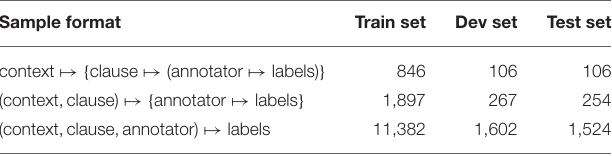
TABLE 1 | Clause-level Fleiss’ κ for the phenomena marking reflective passages. TABLE 2 | Number of samples in training, development and test set.